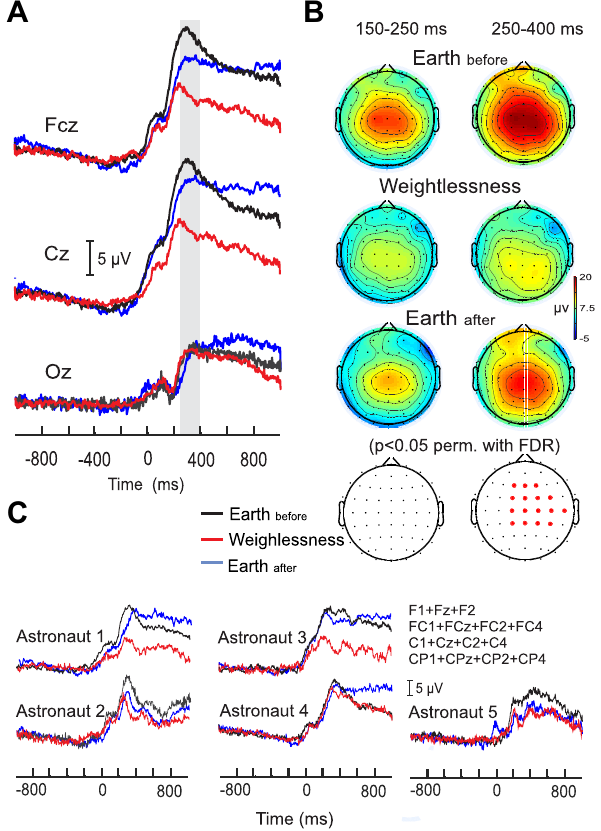
Figure 1. P300 modulation in weightlessness. ( A ) Grand average of the ERP with respect to the press button (for docking) of the five astronauts, on Earth before (black lines), in Weightlessness (red lines) and on Earth after (blue lines), in FCz, Cz and Oz electrodes. The grey bar highlights the 250–400 ms period where significant differences were found for the full array of electrodes as illustrated in ( B ). ( B ) Grand average of the topographical voltage distribution and the statistical differences of the three conditions (Earth before , Weightlessness and Earth after ). ( C ) ERP traces for each of the five astronauts for the three conditions Earth before (black lines), Weightlessness (red lines) and Earth after (blue lines). Each trace is the averaged signal of the significant electrodes obtained by the topographical statistical analysis in ( B